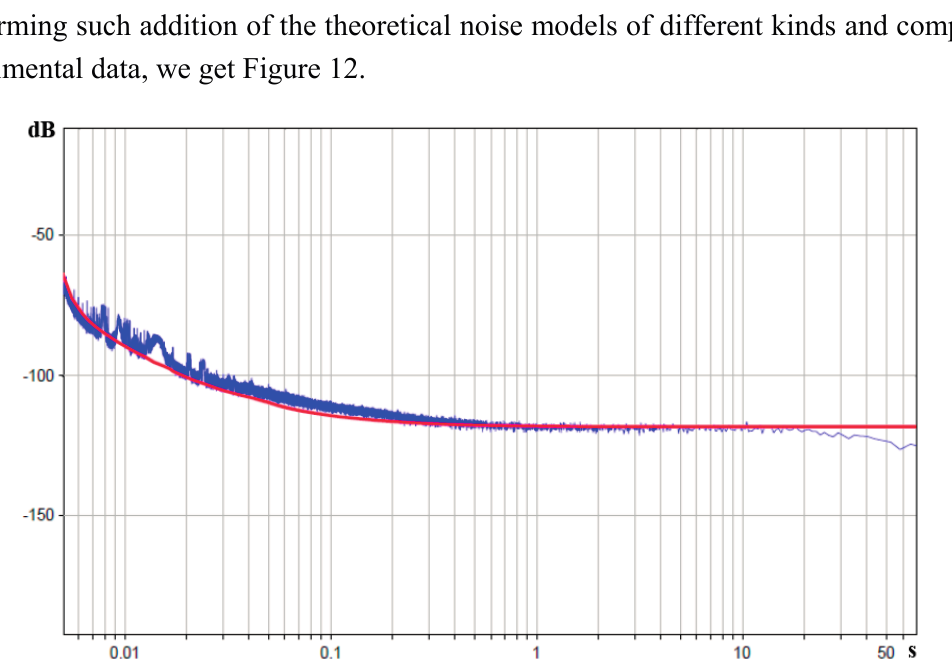
Figure 12. Power spectral density of molecular electronic sensor noise in units of input angular acceleration in decibels relative to 1 rad/s 2 / √Hz is the blue curve, theoretical curve corresponding to root-mean-square sum of three noise mechanisms is the red curve. The X-axis is the periods in